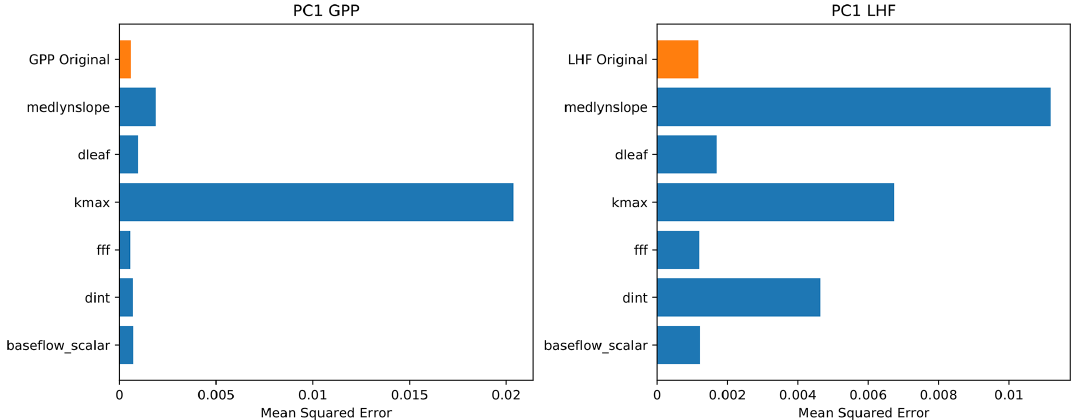
Figure 7. Permutation feature importance test of PC1 for GPP and LHF from the neural network emulators. The top bar (in orange) shows the mean squared error without any permutation (original model skill), and each row (in blue) shows the emulator performance when the information from each parameter is removed, one at a